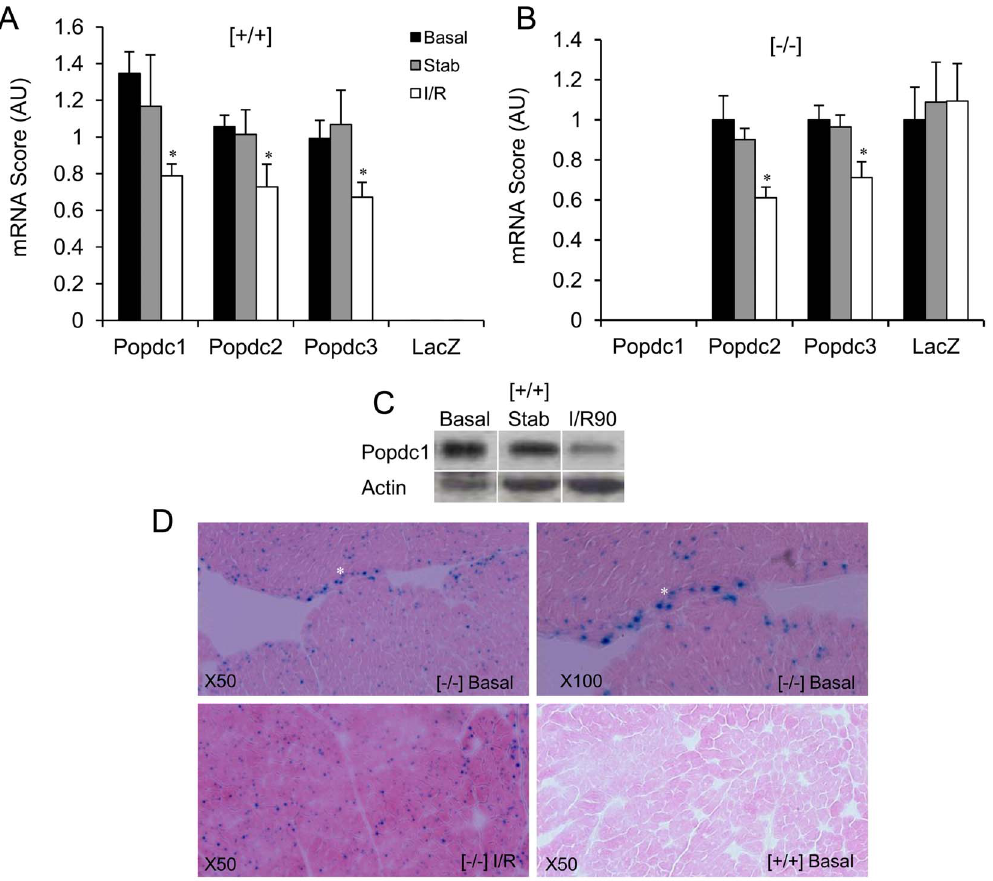
Figure 8. Popdc1 is down regulated by I/R. (a) and (b) RT-qPCR of Popdc1-3 and LacZ mRNAs from hearts isolated upon heart removal (Basal), at the end of stabilization (Stab) and at 90 min reperfusion (I/R). N=5/group. AU, arbitrary units, Mean 6 SEM; *P , 0.05 compared to Basal. (c) Western blots of Popdc1 in WT hearts (Popdc1, , 68 kDa; Actin, , 42 kDa). (d) Cytochemical staining of LacZ activity (blue nuclei). Note, a higher intensity in subendocardial cells (white asterisk). Eosin counterstaining illustrates the general morphology. Images were captured at X50 and X100 magnification, as specified.